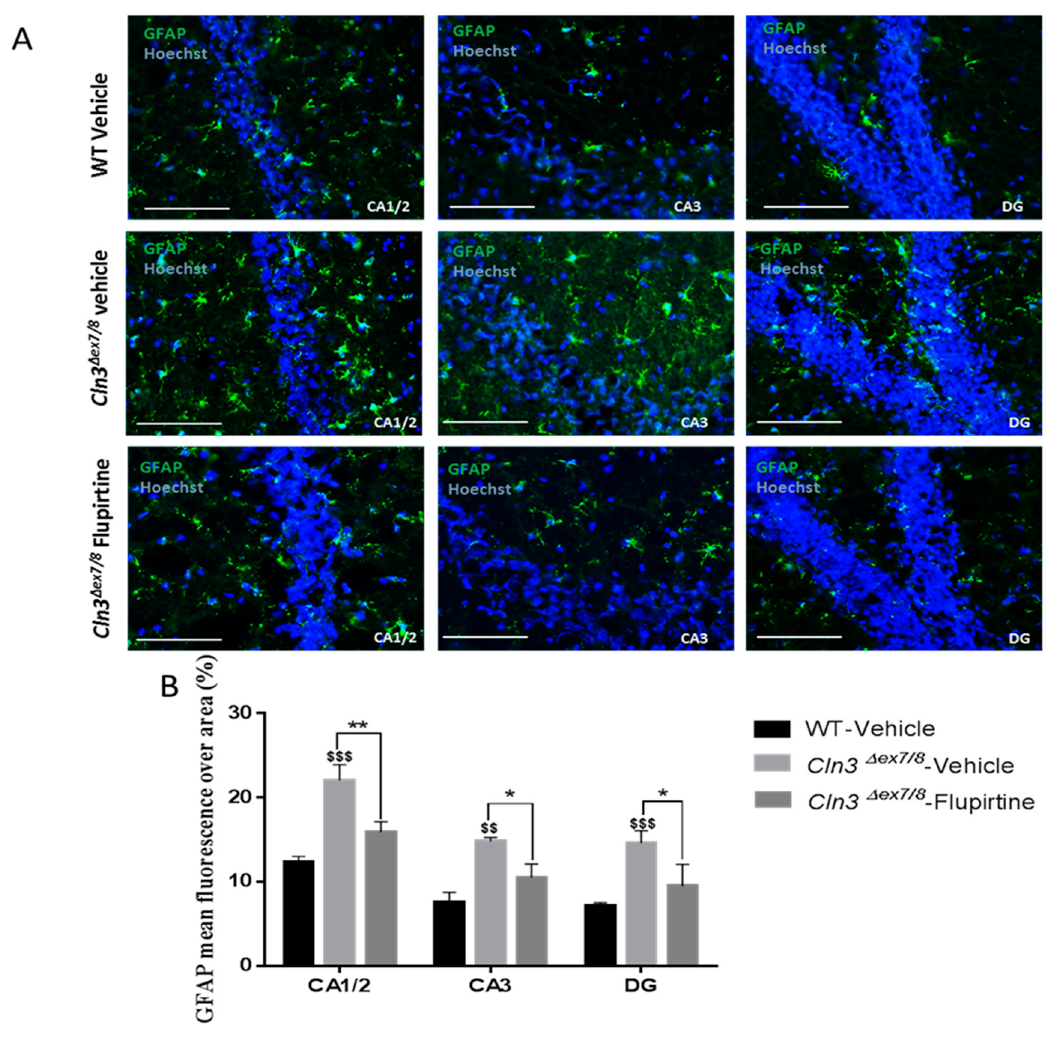
Figure 7. Impact of flupirtine supplementation on astrocytosis in hippocampus and motor cortex of female Cln3 ∆ ex7 / 8 mice. ( A ) Representative images of hippocampus regions CA1, CA2, CA3 and dentate gyrus (DG), from vehicle-treated WT, vehicle-treated Cln3 ∆ ex7 / 8 , and flupirtine-treated Cln3 ∆ ex7 / 8 female mice stained with GFAP in green and counterstained with Hoechst in blue ( n = 4; scale bars = 20 µ m).; ( B ) glial fibrillary acidic protein (GFAP) mean fluorescence over area in vehicle-treated WT, vehicle-treated Cln3 ∆ ex7 / 8 , and flupirtine-treated Cln3 ∆ ex7 / 8 male mice in hippocampus regions CA1, CA2, CA3 and dentate gyrus (DG), as well as in primary motor cortex (MC). Data are expressed as mean ± SEM. $ p: compared to vehicle-treated WT, * p : compared to vehicle-treated Cln3 ∆ ex7 / 8 . * p < 0.05, ** p < 0.01, $$ p < 0.01, and $$$ p <